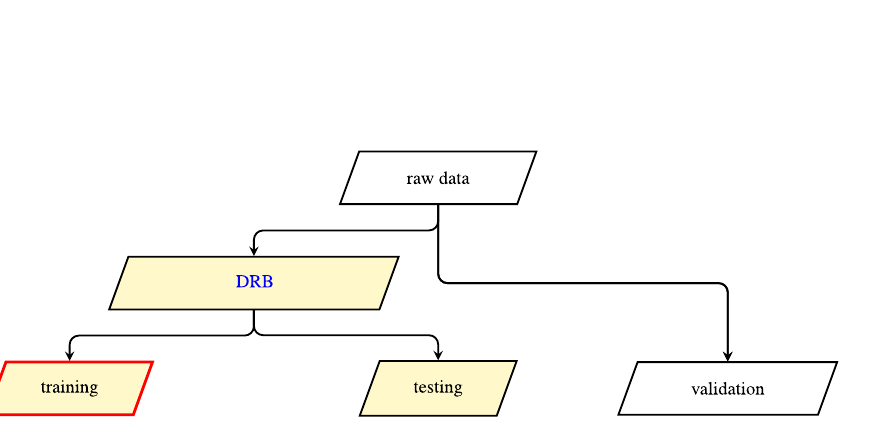
Figure 9. Conceptual description of data set splittings. The data was split before the DR process and once again before the classifier training. Yellow nodes took part in the DR process. The red border denotes that training was used to fit the classifier. Generated withpgf